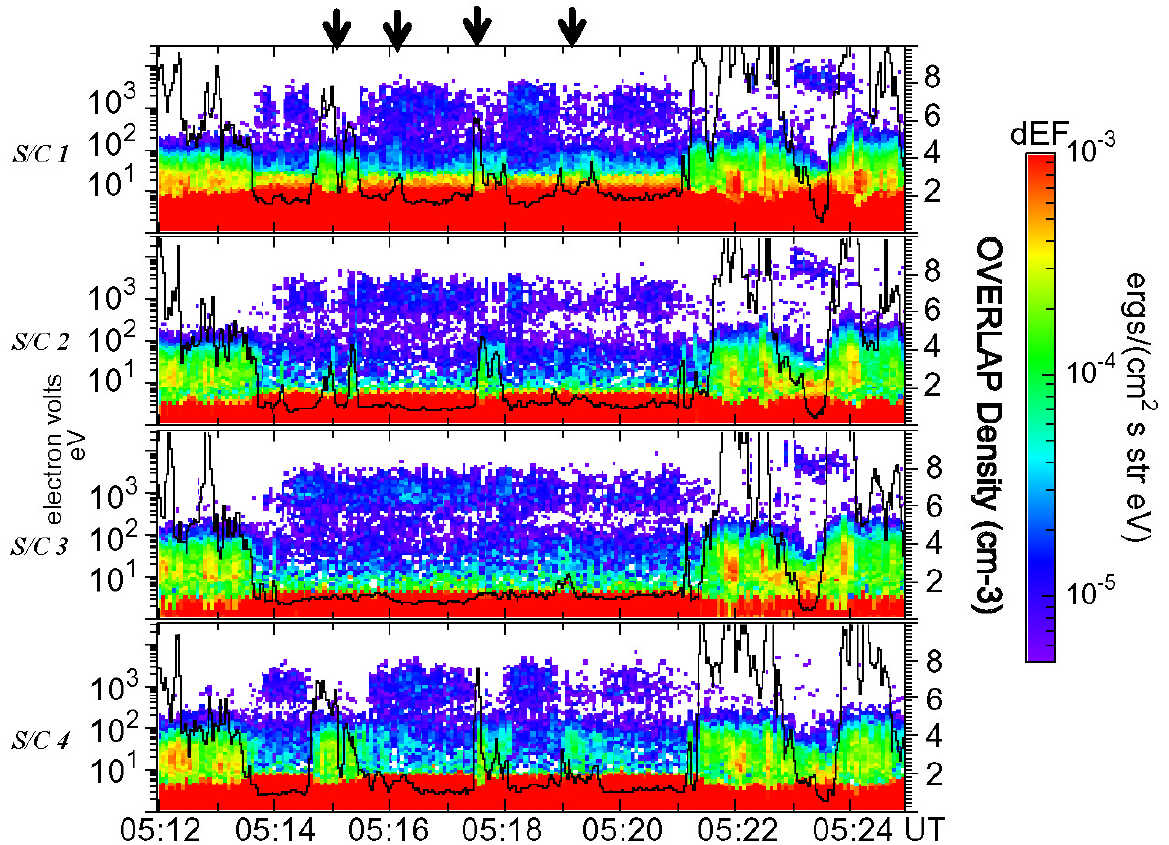
Fig. 4. Top panel shows Cluster 1 data through to Cluster 4 data in the bottom panel. Data is in energy-time spectrogram format, detailing the higher energy magnetospheric population, which is found predominantly in the perpendicular component of the pitch angle distribution. The arrows indicate the transient cusp/cusp boundary layer population appearances discussed in the text, where minimal spectral flux enhance- ments occur at Cluster 3, suggesting that the structures have a scale size of the order of the spacecraft separation. The black over-plotted line is PEACE density from the OVERLAP region, to accentuate the plasma